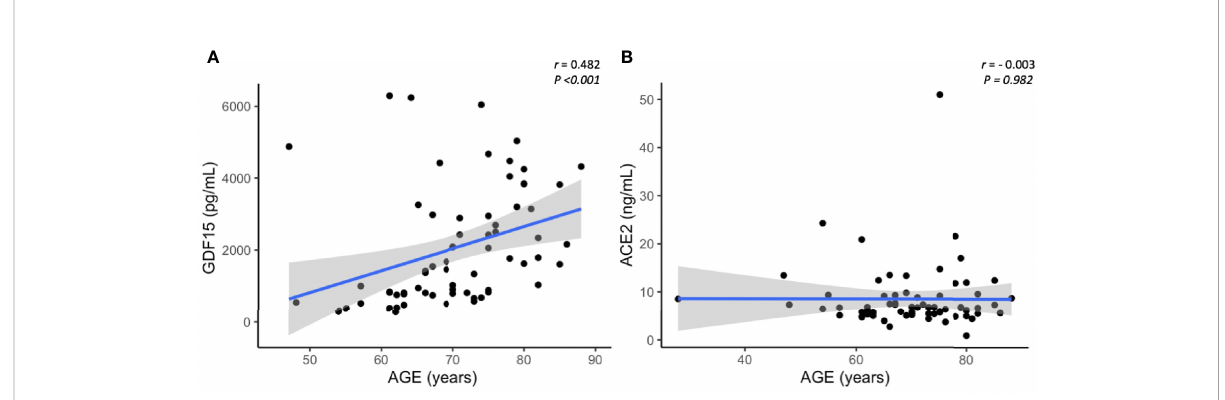
FIGURE 3 Representative scatterplots showing the association between GDF15 and ACE2 levels with age. GDF15 is positive associated with age (A) , while ACE2 is not correlated with age (B) . Each dot represents an individual value. The solid blue line represents the regression line. The grey shade represents the con fi dence interval.